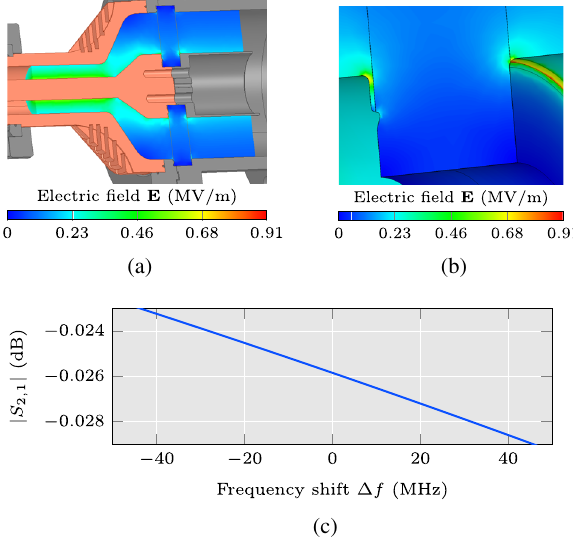
FIG. 12. Electric field amplitude at the taper and PEEK window of the input power coupler when 65 kW are transmitted (a). The maximum field of 0 . 91 MV = m is located at the contact of the PEEK window and the inner conductor of the coaxial waveguide (b). The transmission loss through PEEK window and taper is shown in